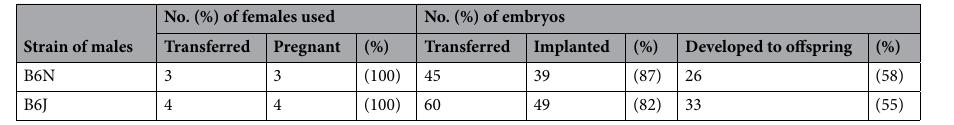
Table 2. Full-term development of embryos fertilized in vitro using spermatozoa frozen by the EQ method and stored for 1 month. There were no significant differences in the implantation and birth rates between strains using Fisher’s exact test.